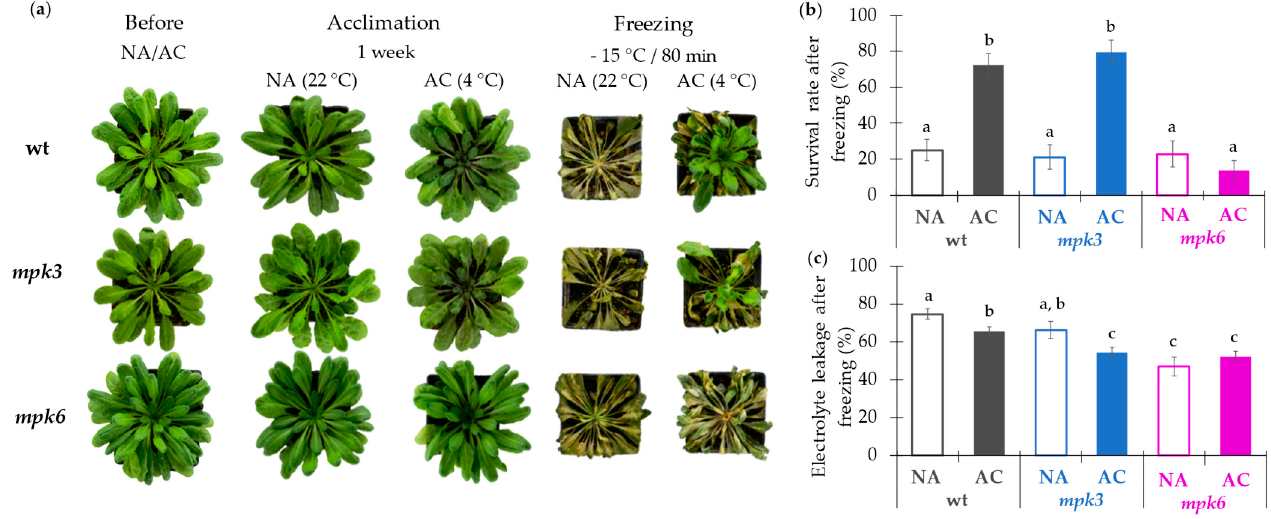
Figure 1. Effect of acclimation and freezing temperatures on the phenotype, survival rate, and electrolyte leakage from wild type, mpk3 , and mpk6 plants. Wild type (wt), mpk3 , and mpk6 plants were grown at 22 ◦ C for 10 weeks and then subjected to non-acclimation (NA) or acclimation (AC) treatment. For the NA treatment, plants were maintained at 22 ◦ C for another week. For the AC treatment, plants were transferred to a chamber at 4 ◦ C for one week. Then NA and AC plants were shifted to a freezing chamber at − 15 ◦ C for 80 min under dark conditions (freezing challenge). For recovery, all plants were moved at 4 ◦ C under dark conditions for 80 min and then to 22 ◦ C for one-week (see Figure S1 for experimental design). ( a ) Acclimation and freezing-tolerant phenotypes. Representative images from NA and AC plants at the end of the acclimation and the recovery periods are shown. Note that plant images are presented at the same scale as denoted for the pot size. ( b ) Survival rate was evaluated at the end of the recovery period. ( c ) Electrolyte leakage was measured immediately after the freezing challenge. Technical details are described under the Materials and Methods section. Representative images are shown from four independent experiments with eight technical replicates each. In ( b , c ), data are mean values of eight biological replicates ± SE. α ≤ 0.05 (ANOVA test). Different letters indicate significant